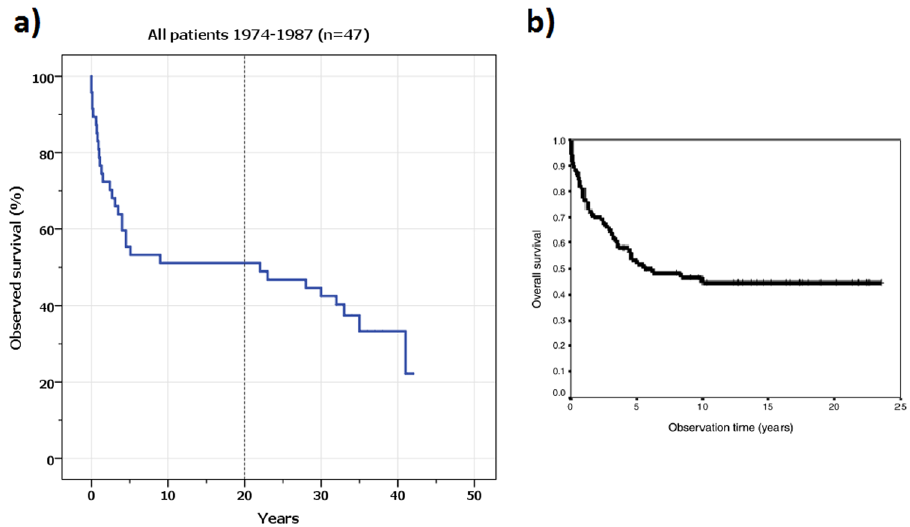
Figure 1. ( a ) Kaplan-Meier curve presenting observed survival for children treated for posterior fossa medulloblastoma between 1974 and 1987 (n = 47). Patients included in the present study (n = 24), i.e. surviving > 20 years, are those right to the dotted line on the abscissa. (b) Kaplan-Meier curve from the publication